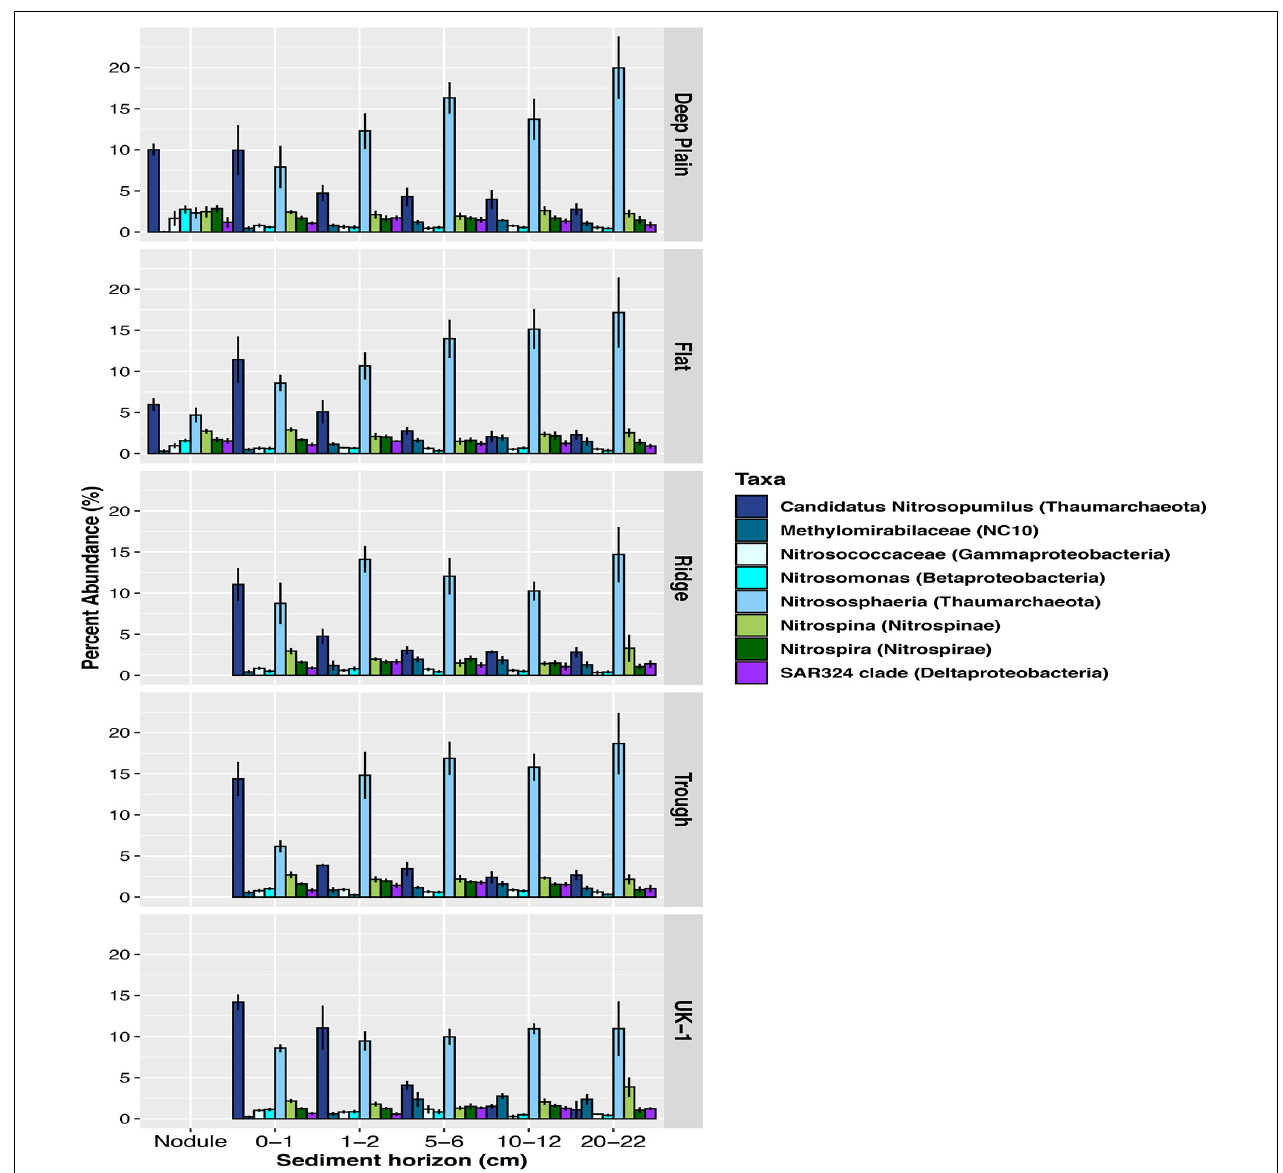
FIGURE 5 | Relative abundances of amplicon sequence variants (ASVs) of the most abundant putative carbon-fixing and nitrifying microbes in sediments and nodules within each region at APEI-6 and at UK-1, defined at genera or family level. The class Nitrososphaeria includes all taxa within that class excluding the genera Candidatus Nitrosopumilus , which is shown in a separate category. Only taxa ≥ 1% relative abundance are shown. Relative abundances were calculated on samples that had first been normalized to account for uneven sampling depth, by scaling sequence counts by library